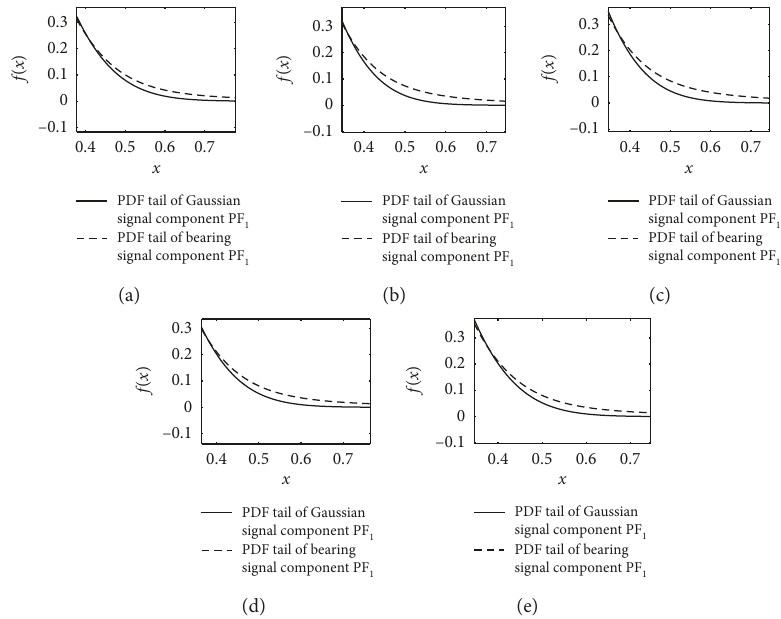
Figure 8: PDF curve comparison of real faulty bearings and Gaussian signals. (a) Normal. (b) Inner race fault 0.1mm. (c) Inner race fault